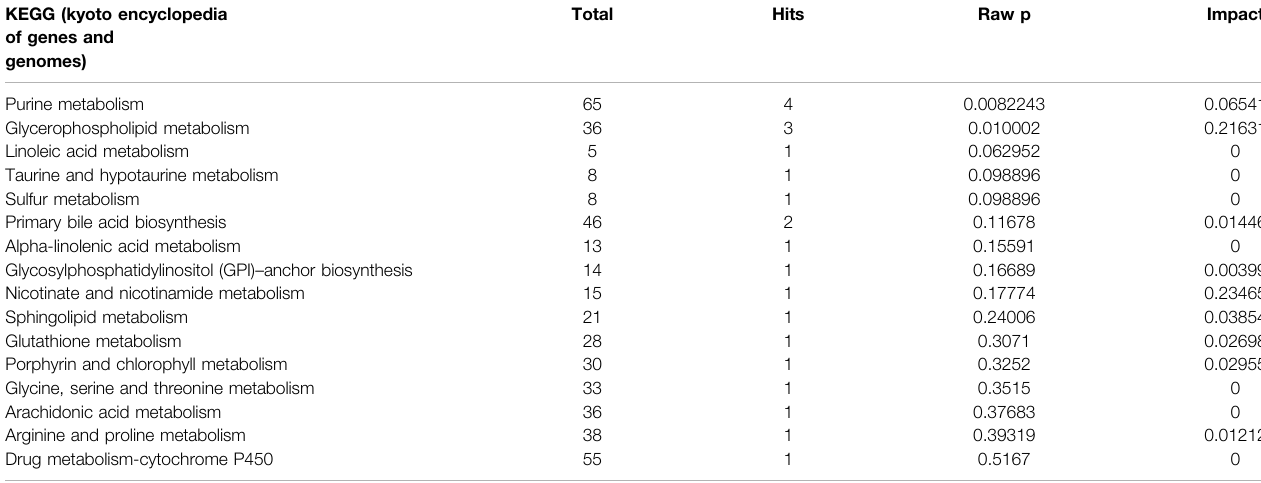
TABLE 1 | Metabolic pathways that signi fi cantly affected by the NTRK1 Arg748Trp variant (in reverse order of comprehensive signi fi cance). KEGG (kyoto encyclopedia of genes and genomes)